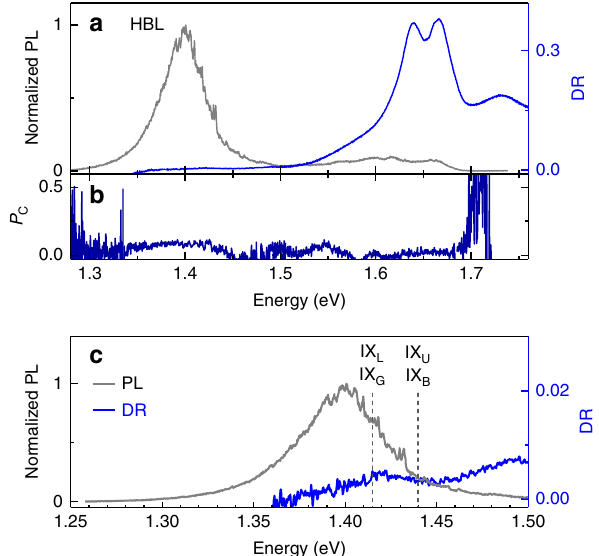
Fig. 1 a Cryogenic PL (gray) and DR (blue) spectra of a vertical MoSe 2 - WSe 2 stack with dominant features of the heterobilayer (HBL) peak in emission and intralayer excitons in absorption. b Degree of circular PL polarization, P C , under circularly polarized excitation. c Zoom-in to the intralayer exciton emission and absorption with energies of zero- momentum bright and gray excitons, IX B and IX G , and momentum-dark spin-like and spin-unlike excitons, IX L and IX U , indicated by dashed lines. The onset of absorption in the DR spectrum at ~1.37 eV stems from the inhomogenously broadened gray interlayer exciton state IX